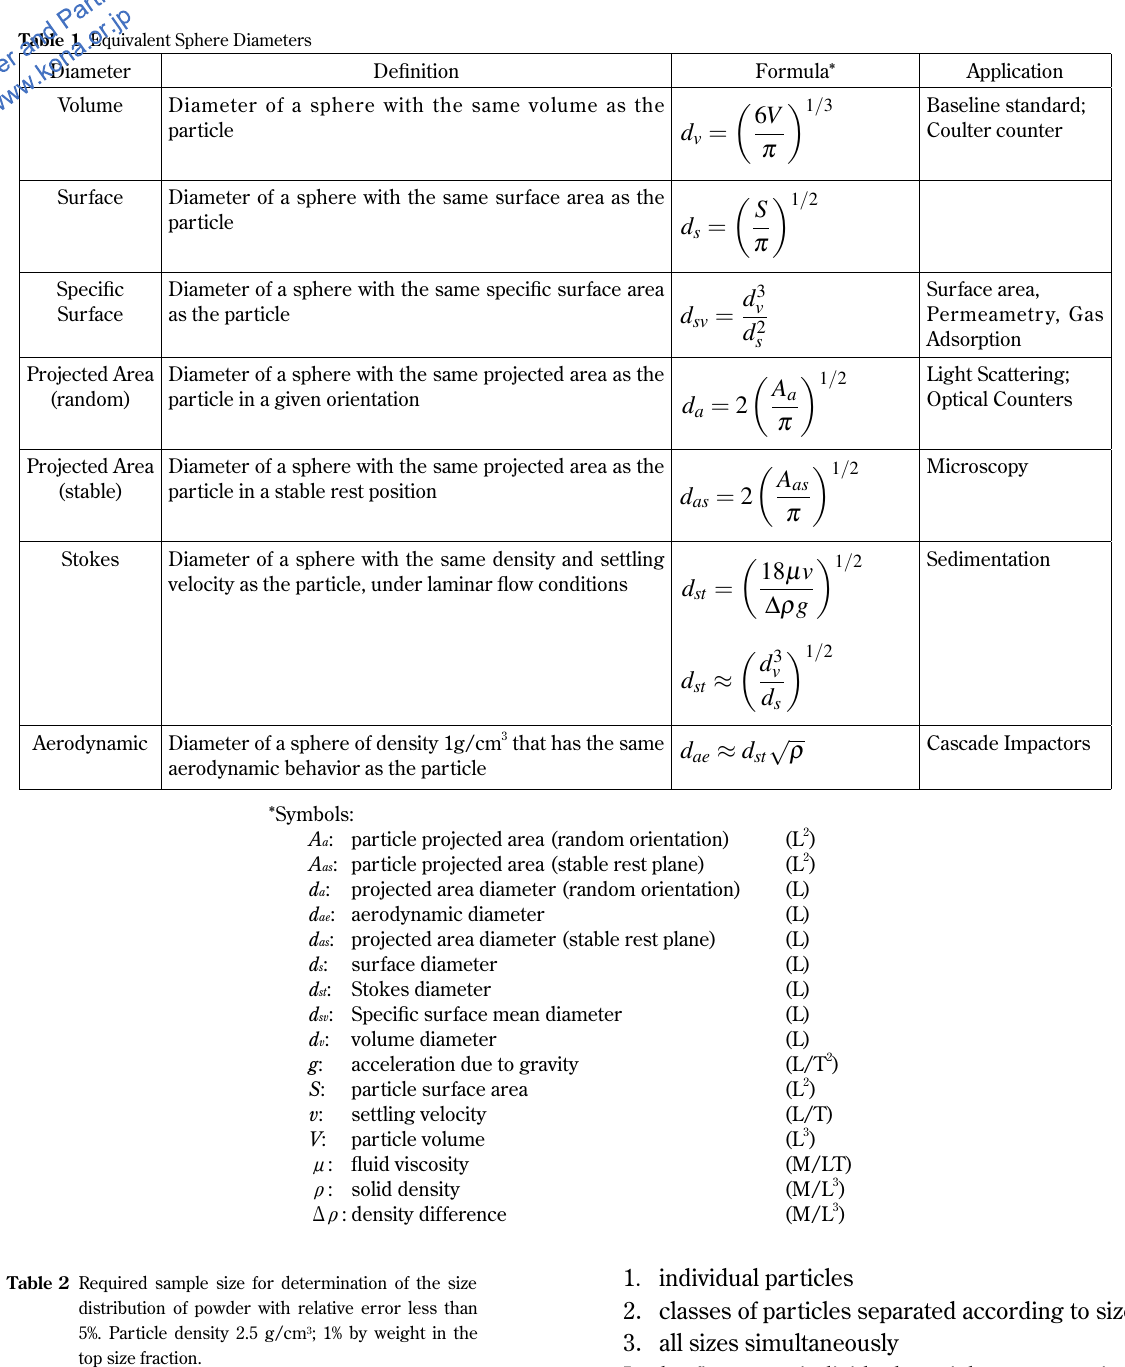
Table 1 Equivalent Sphere Diameters Diameter